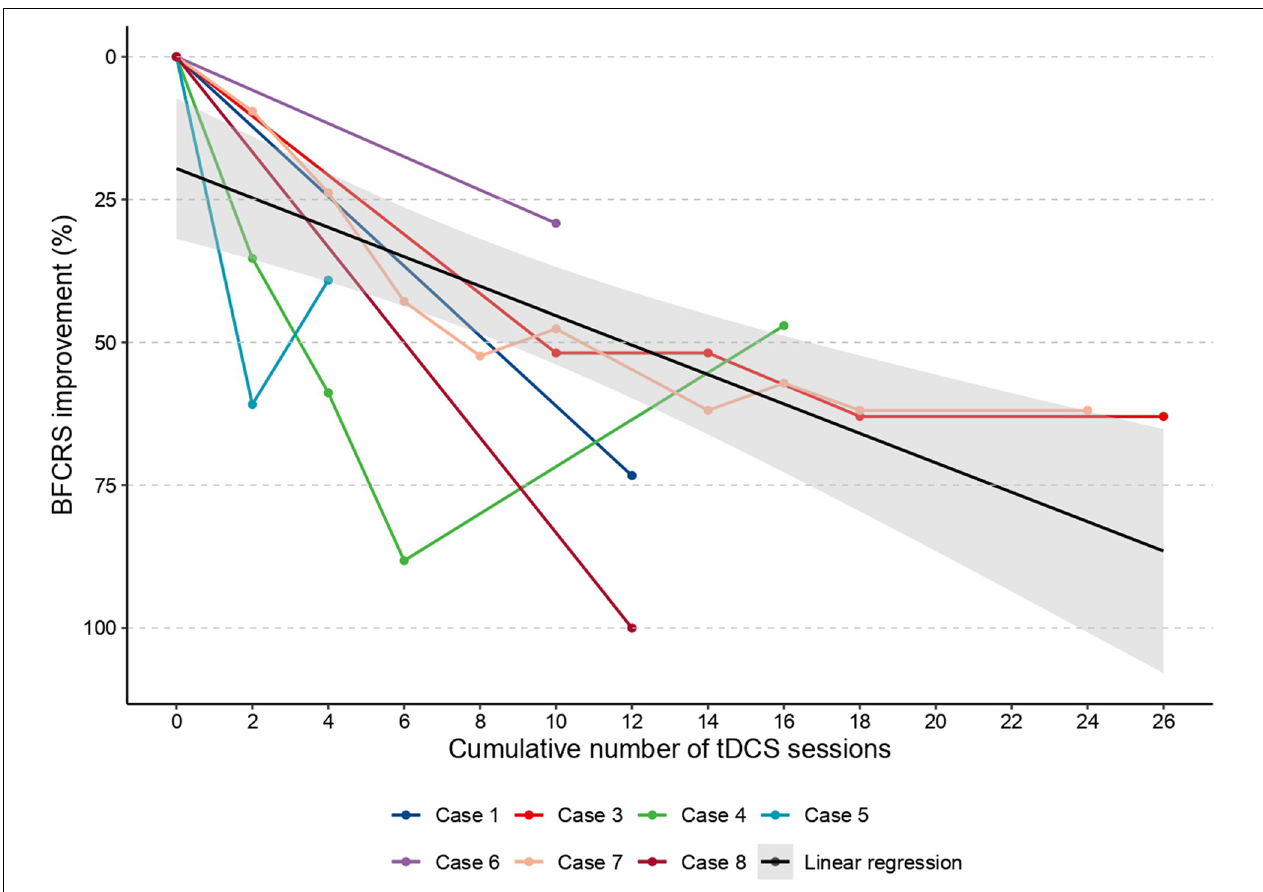
FIGURE 2 | Individual data about the evolution of BFCRS score according to the cumulative number of tDCS sessions. Case 2, for whom catatonia severity was assessed using Kanner scale, is not shown in this figure. In black, the regression line of the scatter